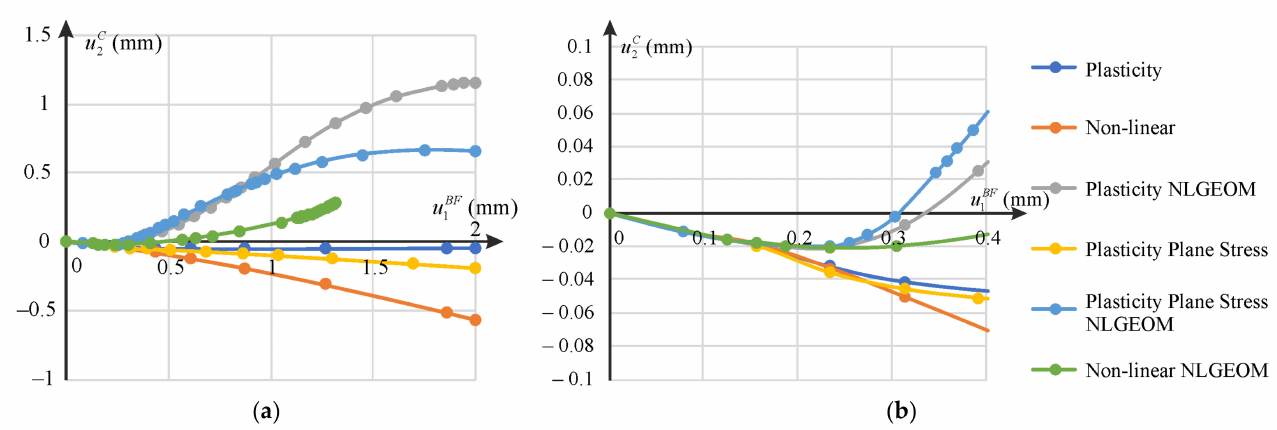
Figure 17. Displacement u 2 of node C as a function of the edge displacement BF: ( a ) u BF